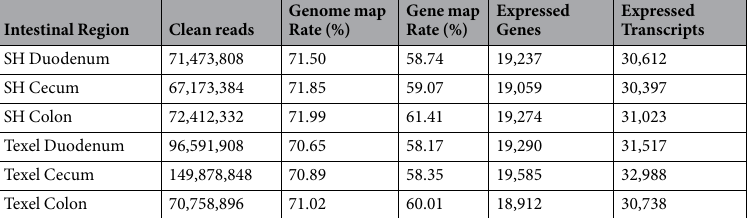
Highly expressed transcripts ( ≥ 500 FPKM) Medium expressed transcripts ( ≥ 10 FPKM to 500 FPKM) Lowly expressed transcripts ( ≥ 1 FPKM to 10 FPKM) Ultra lowly expressed transcripts ( < 1 FPKM) Table 2. Transcript expression profiles from three intestinal